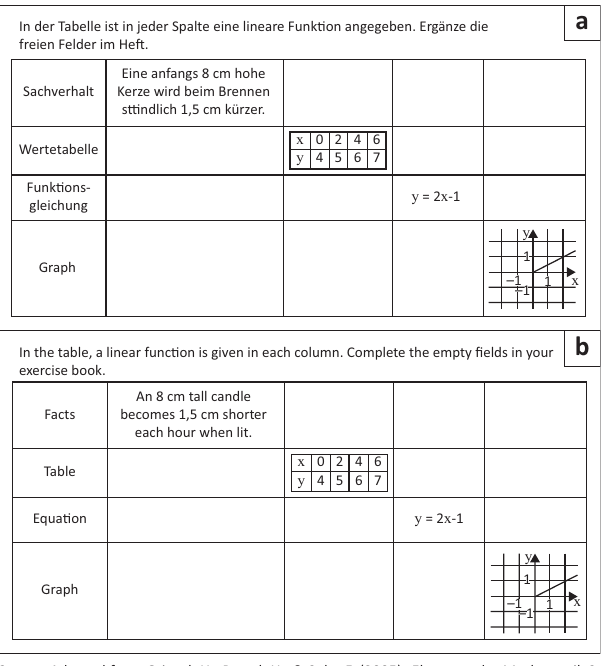
FIGURE 6: Task from Elemente der Mathematik 3 on translating between function representations, (b) translation of the task.